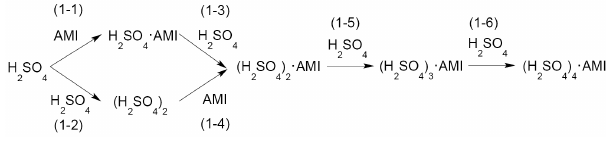
Scheme 1. Direct formation from neutral sulfuric acid clusters ters;